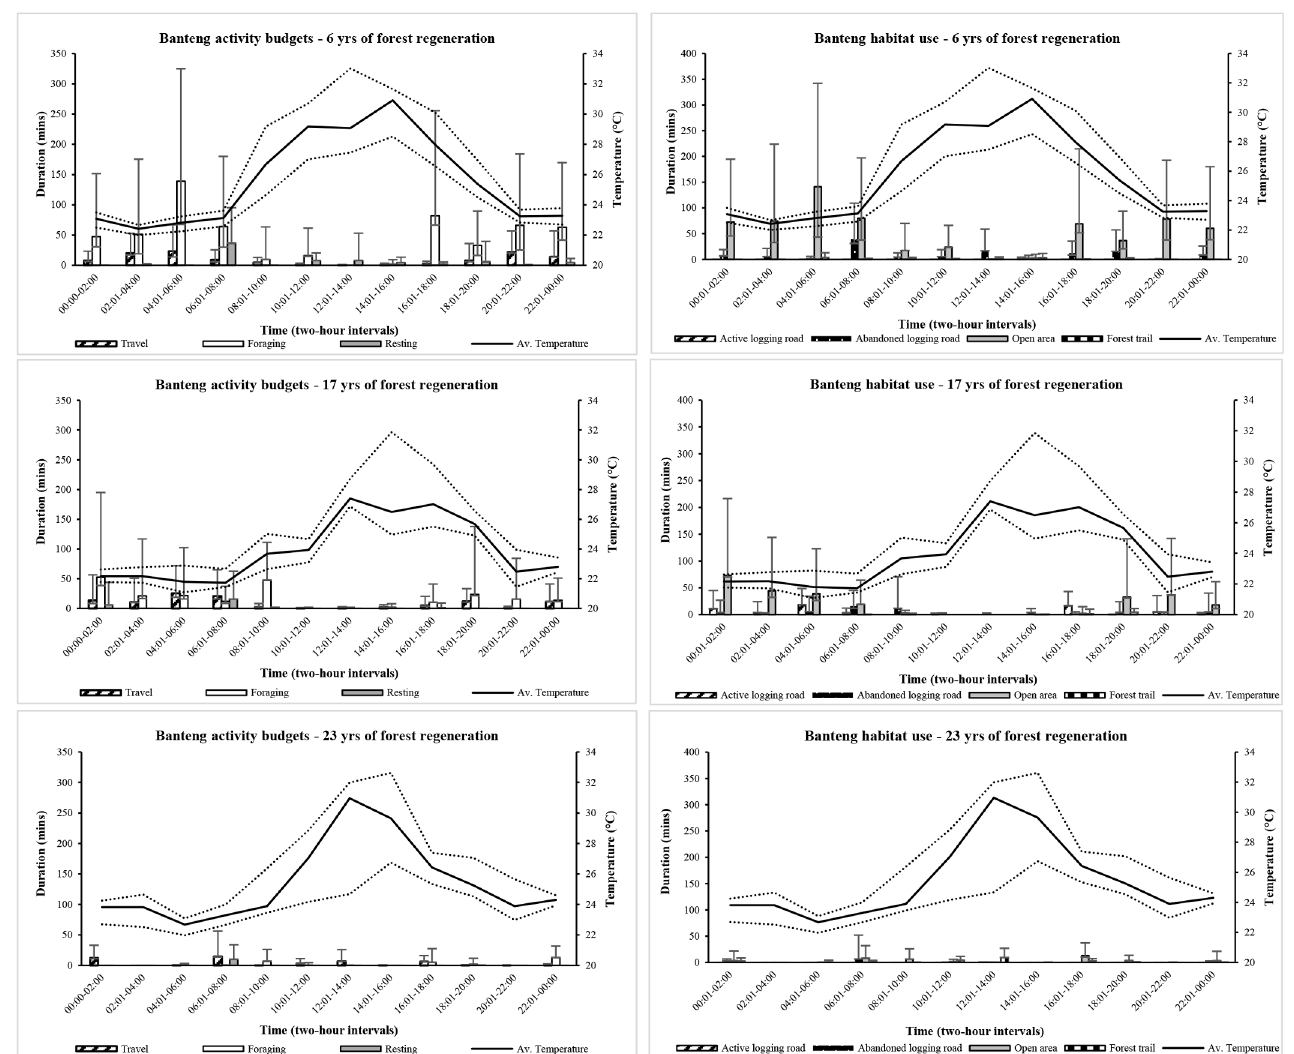
Fig 3. Activity budgets of three specific behaviours, and habitat use of four specific areas, by time and temperature, of Bornean banteng in Sabah recorded using camera traps deployed in three forests, which were at different stages of regeneration following logging activity. Activity, habitat use and temperature data were pooled to two-hour intervals and bootstrapped for 400 iterations to obtain non-parametric 95% confidence intervals around each